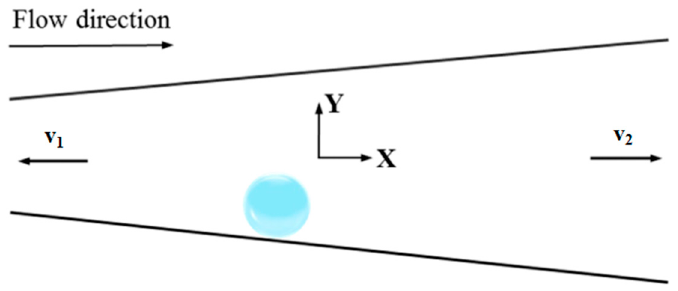
Figure 2. A schematic diagram of the bubble in the nucleation stage.